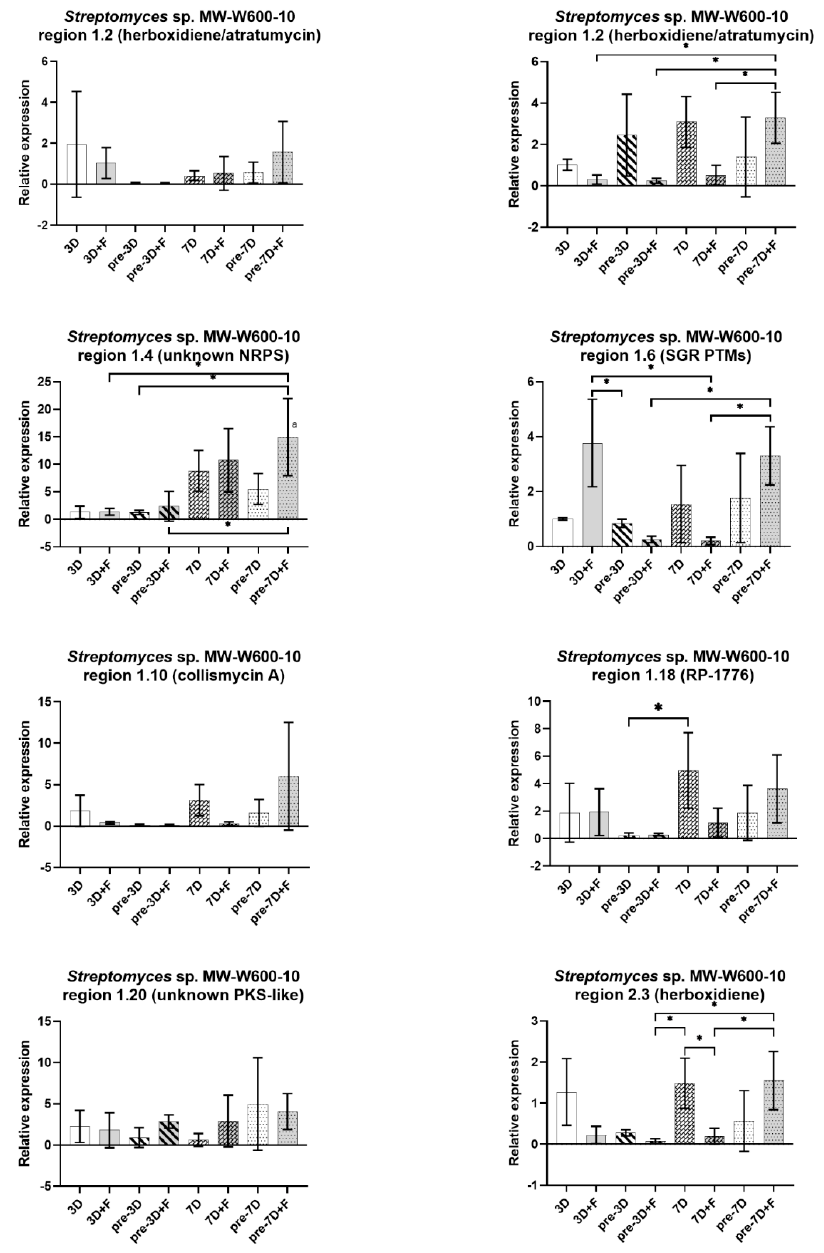
Figure 7. Relative expression of selected BGCs of Streptomyces sp. MW-W600-10 grown as a single culture (3D, pre-3D, 7D, and pre-7D) or in co-culture with F. culmorum DSM62188 (3D + F, pre-3D + F, 7D + F, and pre-7D + F). The strain was cultured in simultaneous (3D and 7D) cultures or with the pre-cultured Streptomyces strain for 3 (pre-3D) or 7 (pre-7D) days. The qPCR was performed on mRNA samples purified from cultures at the 3rd (3D; 3D + F), 6th (pre-3D; pre-3D + F), 7th (7D; 7D + F), and 14th (pre-7D; pre-7D + F) day of incubation. For each sample, two culture plates were used for mRNA purification, and each experimental setup comprised at least 3 biological repeats. The charts show mean values and standard deviations of the expression ratio relative to the control (average of 3D samples) after the removal of outliers. The scale has been adjusted for each cluster separately for better visibility. Statistically significant differences in relative expression levels in different experimental setups are marked by ‘a’ for expression levels significantly different from the expression in the 3D setup; *—significant difference between indicated setups (one-way ANOVA followed by Tukey’s post hoc test, p ≤